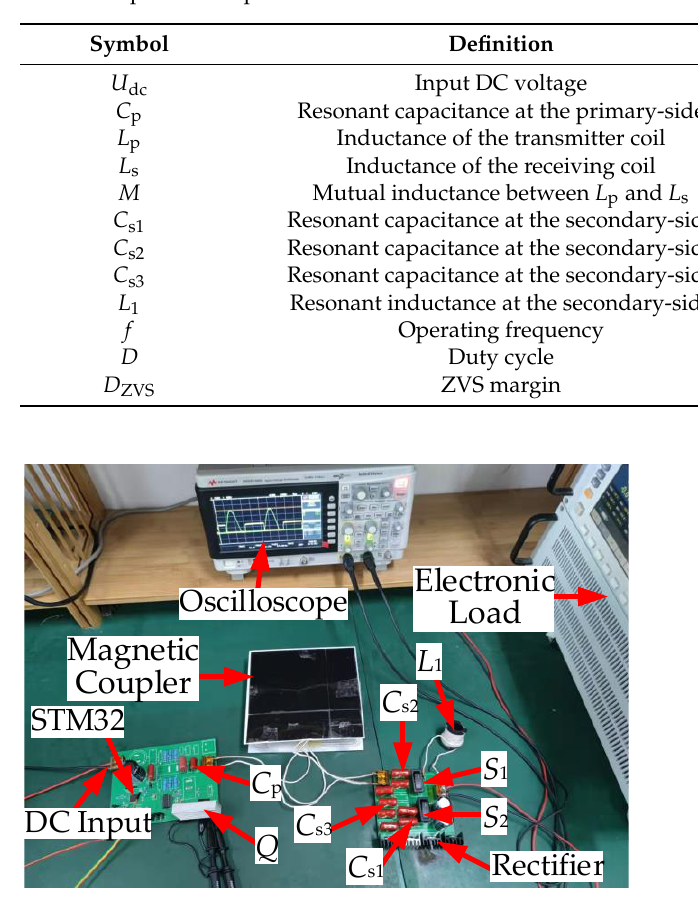
Table 2. Experimental parameters.